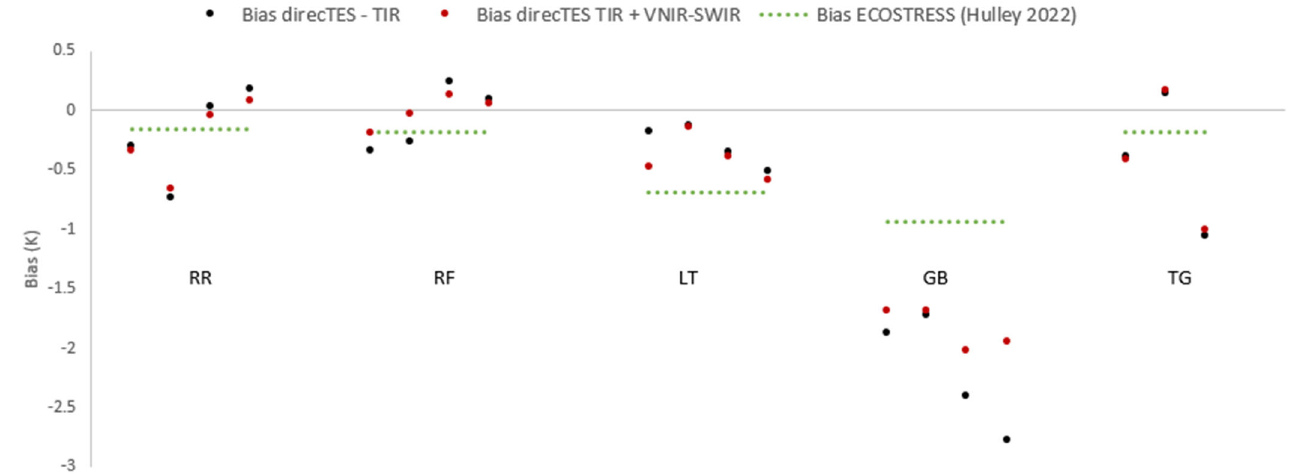
Figure 16. Retrieved bias for L2 ECOSTRESS LST product [36] and for DirecTES TIR and DirecTES TIR + VNIR-SWIR LST on the 5 selected sites.